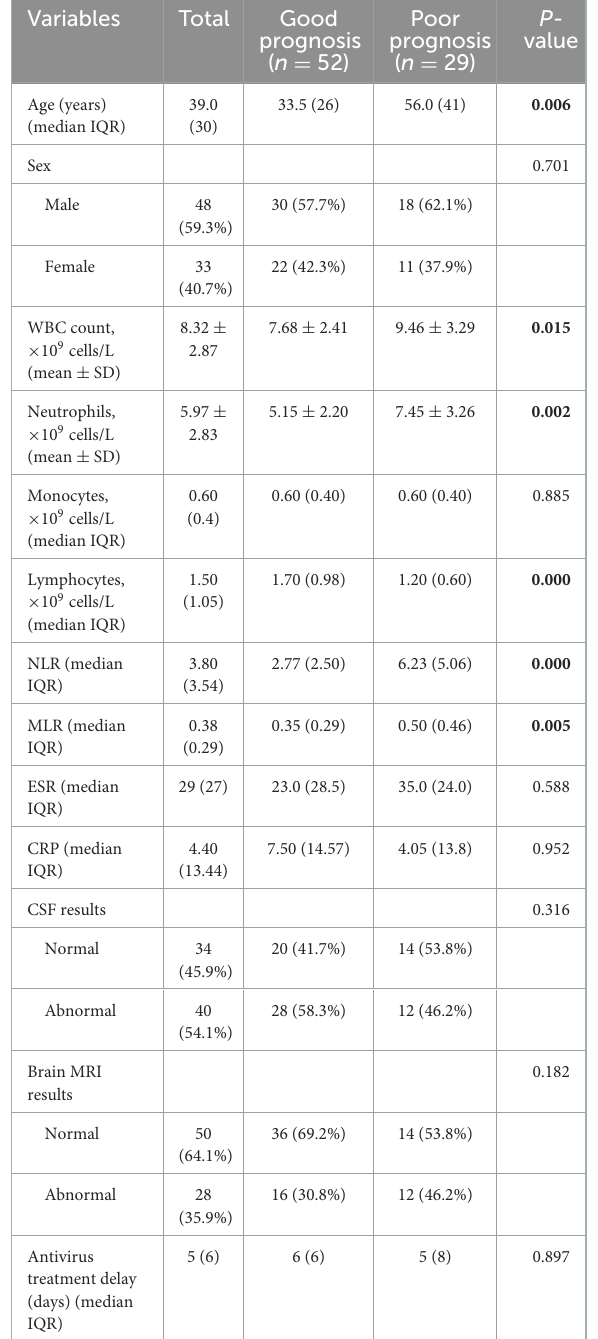
TABLE 1 Basic characteristics of the poor prognosis group compared with the good prognosis group.